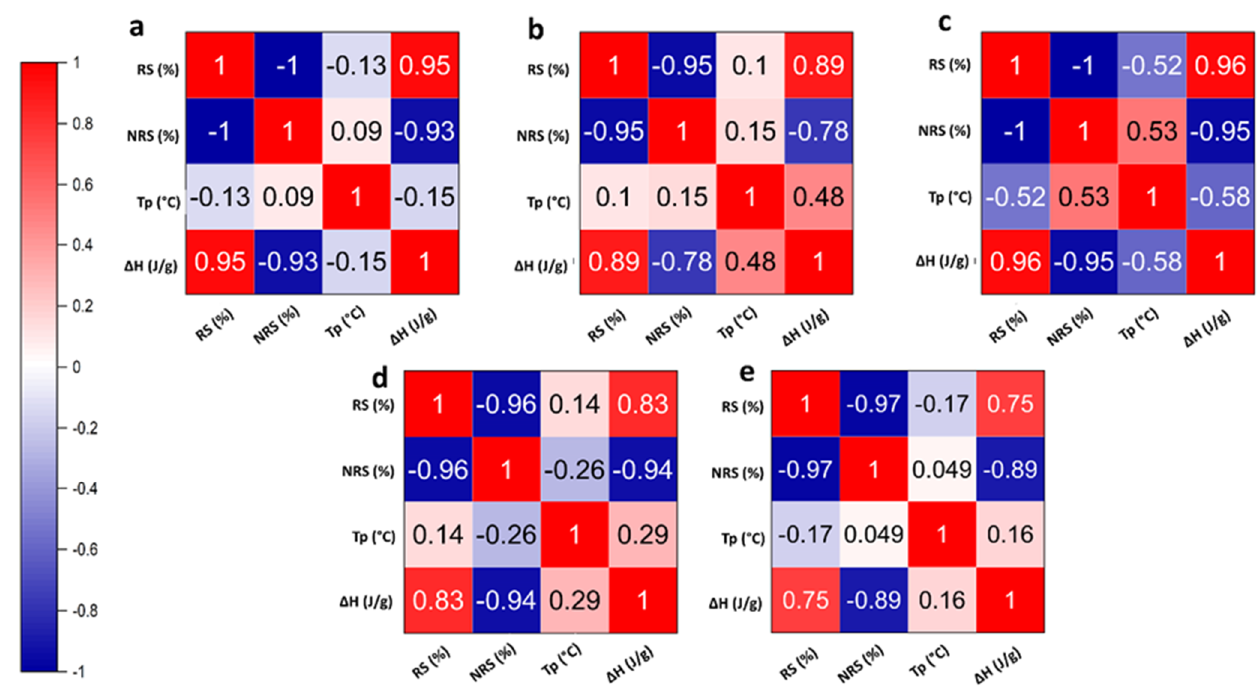
Figure 8. Matrix showing correlation between resistant starch content (RS%), non-resistant starch (NRS %), peak gelatinization temperature (Tp), and gelatinization/retrogradation enthalpy ( ∆ H): ( a ) Diasang lahi, ( b ) Khaju lahi, ( c ) Dhusuri bao, ( d ) Omkar, and ( e ) Bili rajamudi .